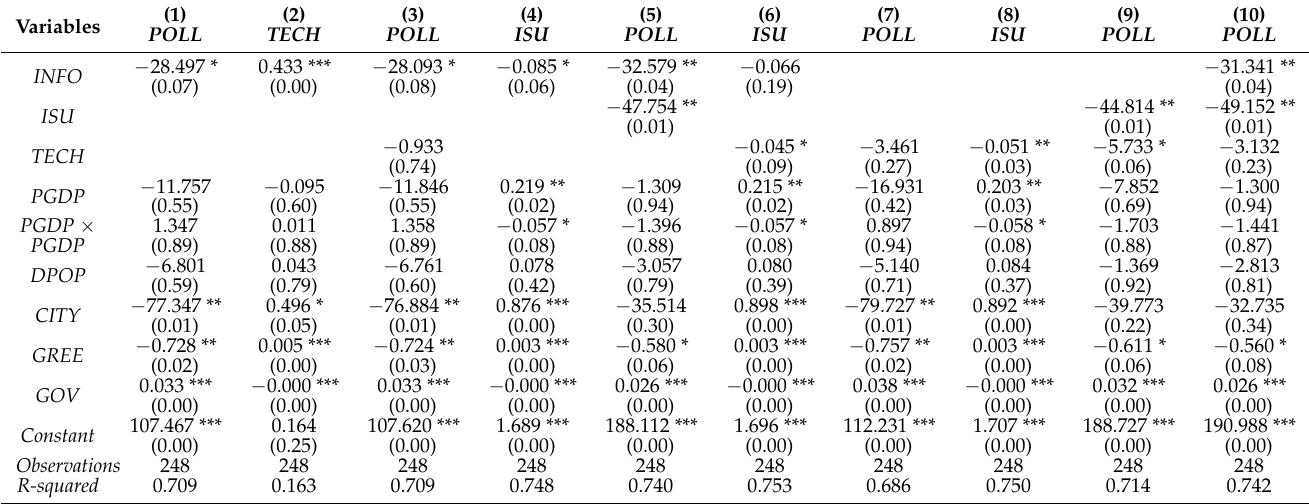
Table 6. Results of stepwise regression mediating effect